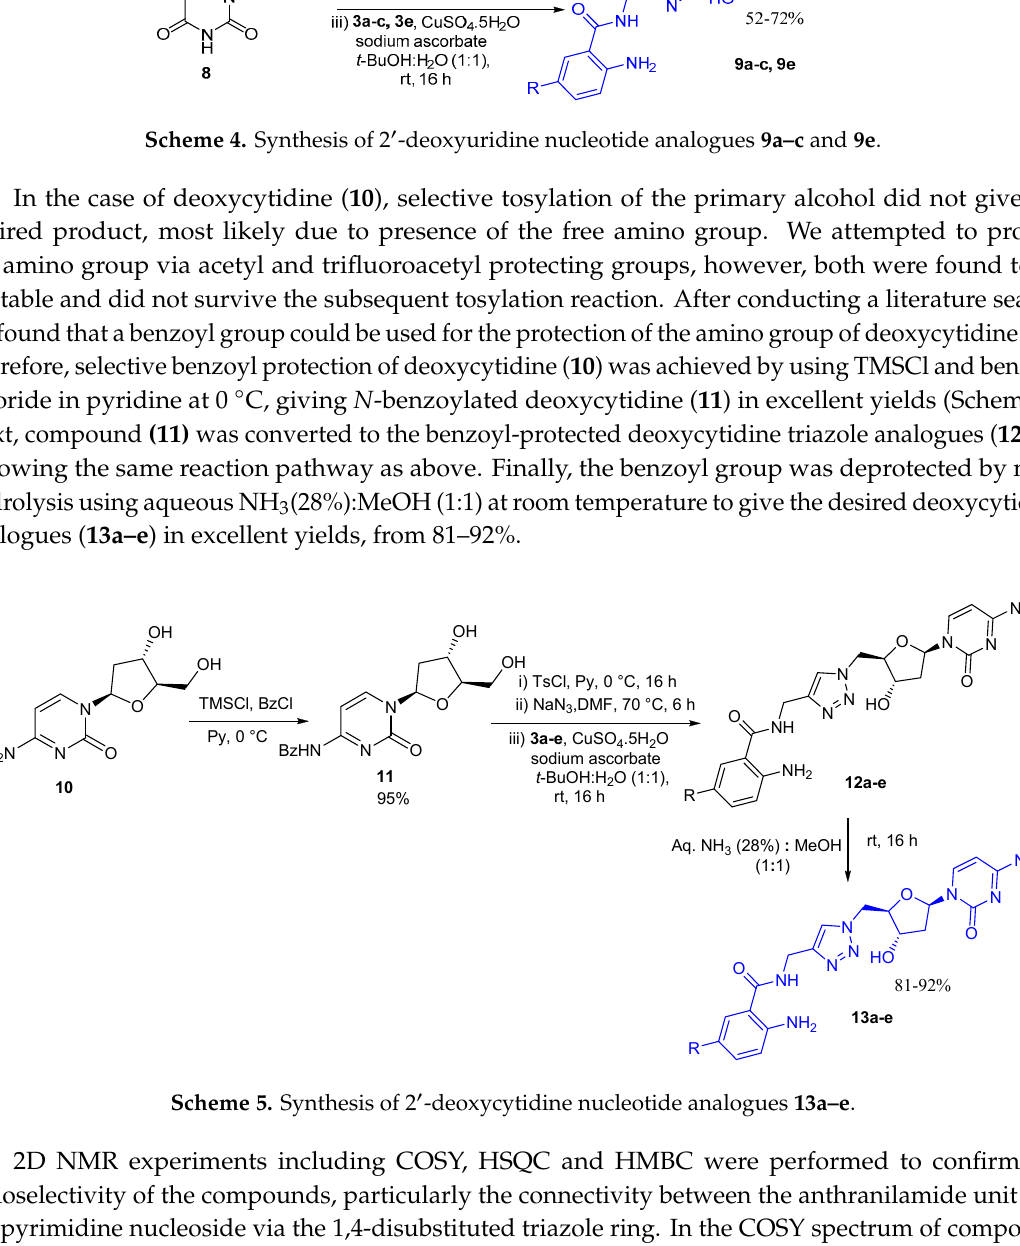
Figure 5. Key COSY and HMBC correlations in compound 13a. 3. Results and Discussion Biological Activity For PQS inhibition assay, all the new triazole nucleotide analogues were screened for their ability to inhibit the pqs QS system using the PAO1 (a P. aeruginosa reporter strain) pqsA:gfp reporter assay. This assay measures the PqsR (MvfR) regulated expression of the pqsABCDE operon. It is expected that the PqsA inhibitors will block the biosynthesis of PQS and HHQ, which leads to lower activation of the PqsR (MvfR) receptor and ultimately, reduction in the expression of the pqsABCDE reporter. The expression of the reporter in the untreated control reached its maximum level after 6–8 h which then fell to basal expression levels at later time points. A known inhibitor of PQS was employed as a positive control which prevented this expression [33]. Preliminary assays revealed that concentrations of DMSO above 1.25% inhibited GFP expression of the reporter, even without the presence of any of the test compounds, although growth was unaffected. Therefore, the final